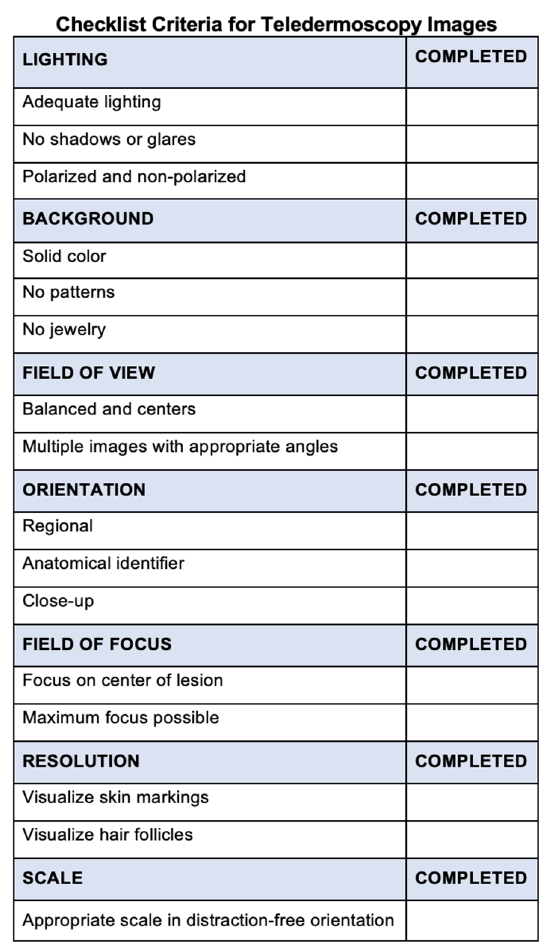
Figure 6. Checklist criteria for teledermoscopy images. The checklist provides recommendations to